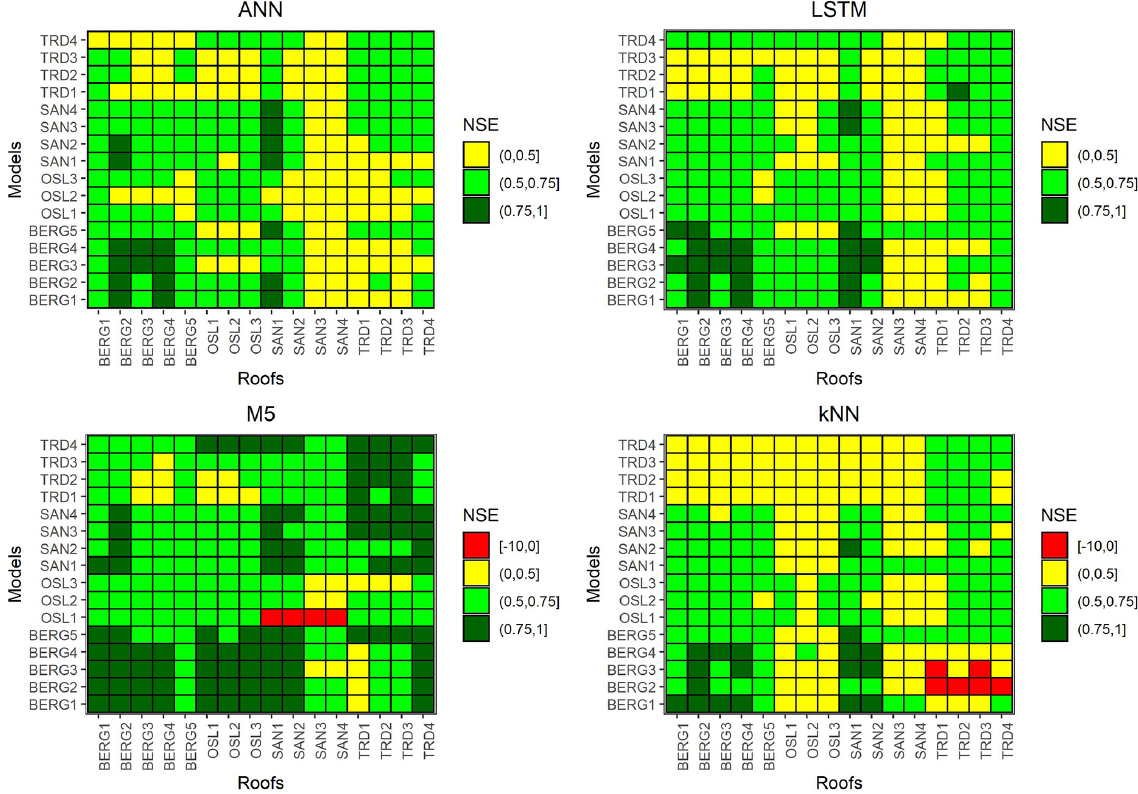
Figure 9. Transferability between the different roofs (NSE). Models on the y axis are used to simulate the measured green roofs on the x